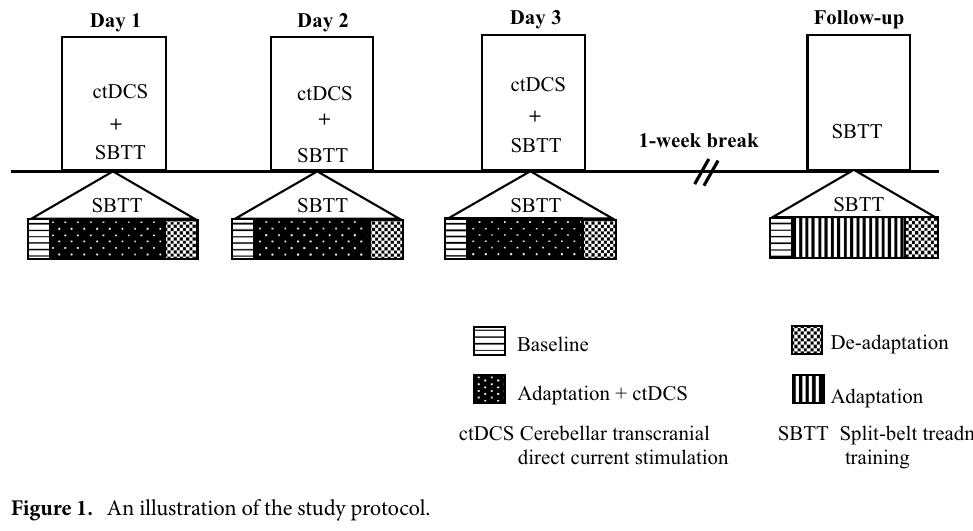
Figure 1. An illustration of the study protocol.